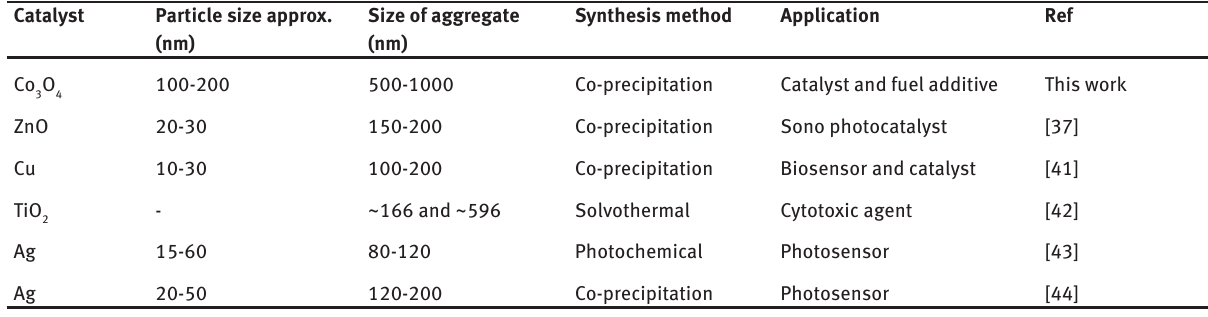
Table 1: Summary of size, synthesis method and applications of different aggregates. Catalyst Particle size